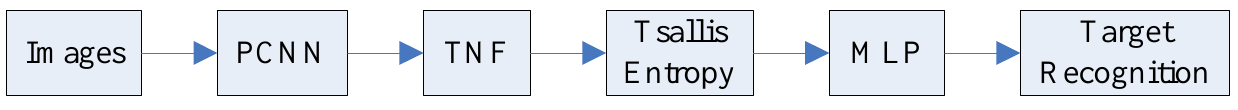
Figure 1. The architecture of the recognition